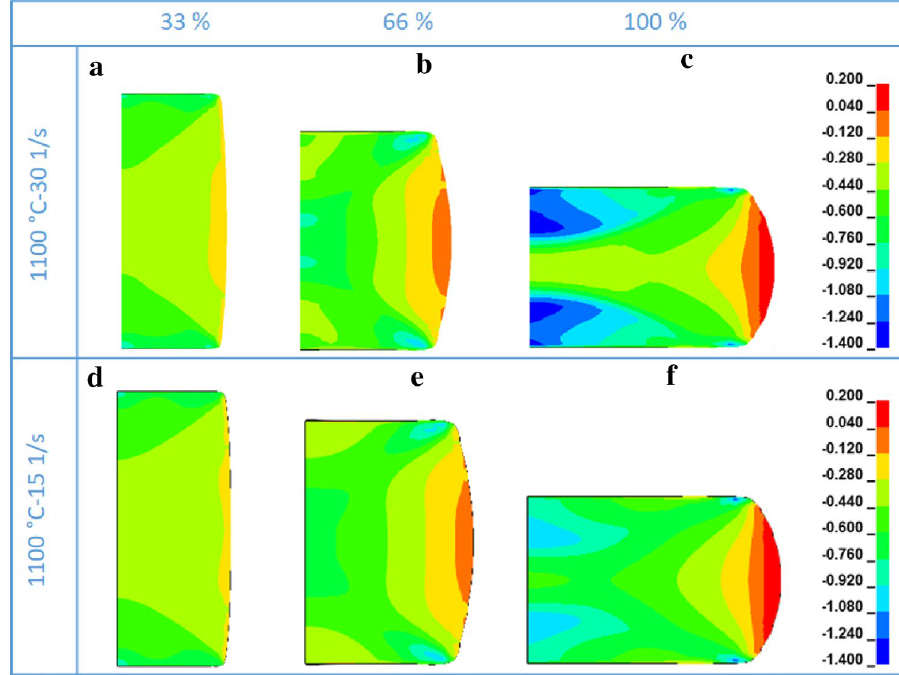
Fig. 8 Triaxiality at 1100 °C at three different stages during compression: 33, 66, and 100% of total